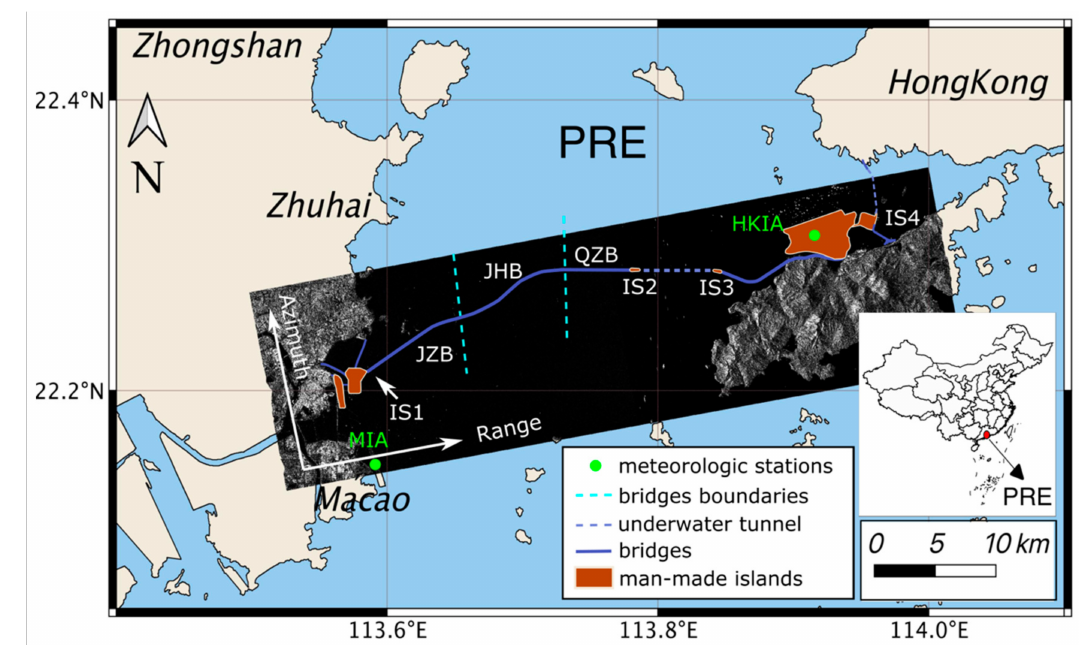
Figure 1. The study area of the Hong Kong–Zhuhai–Macao Bridge (HZMB), consisting of Jiuzhou Bridge (JZB), Jianghai Bridge (JHB) and Qingzhou Bridge (QZB), is located at the Pearl River Estuary (PRE) as indicated in the inset. The western segment of the HZMB is connected with the eastern segment via one underwater tunnel between the western (IS2) and eastern (IS3) man-made islands. (IS1: reclaimed island for the Zhuhai–Macao Passenger Terminals, and IS4: reclaimed island for the Hong Kong Passenger Terminal). The two green dots show the location of two meteorologic stations in the Hong Kong International Airport (HKIA) and Macao International Airport (MIA). The background image is an intensity image of the Sentinel-1A acquisition on 30 May